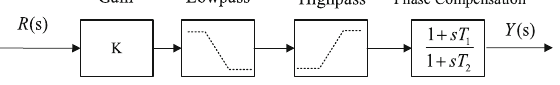
Fig. 8 Structure of SDC